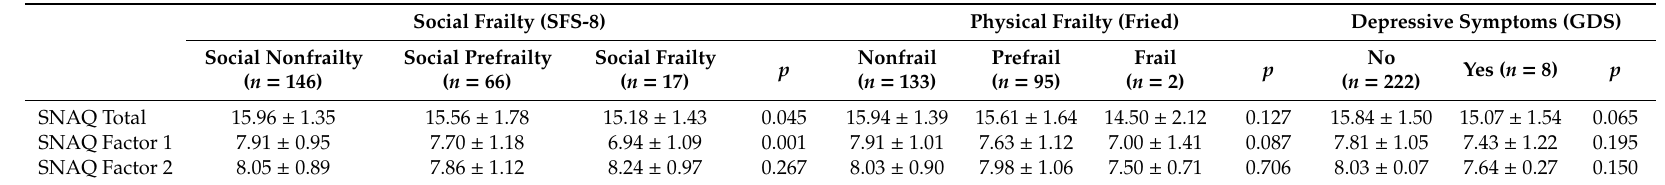
Table 5. Concurrent Validity of